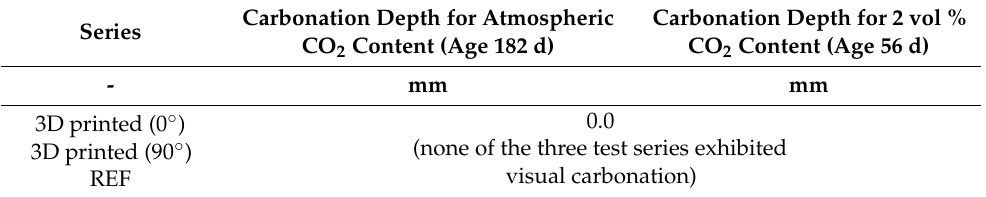
Table 1. Carbonation depths of the test series.